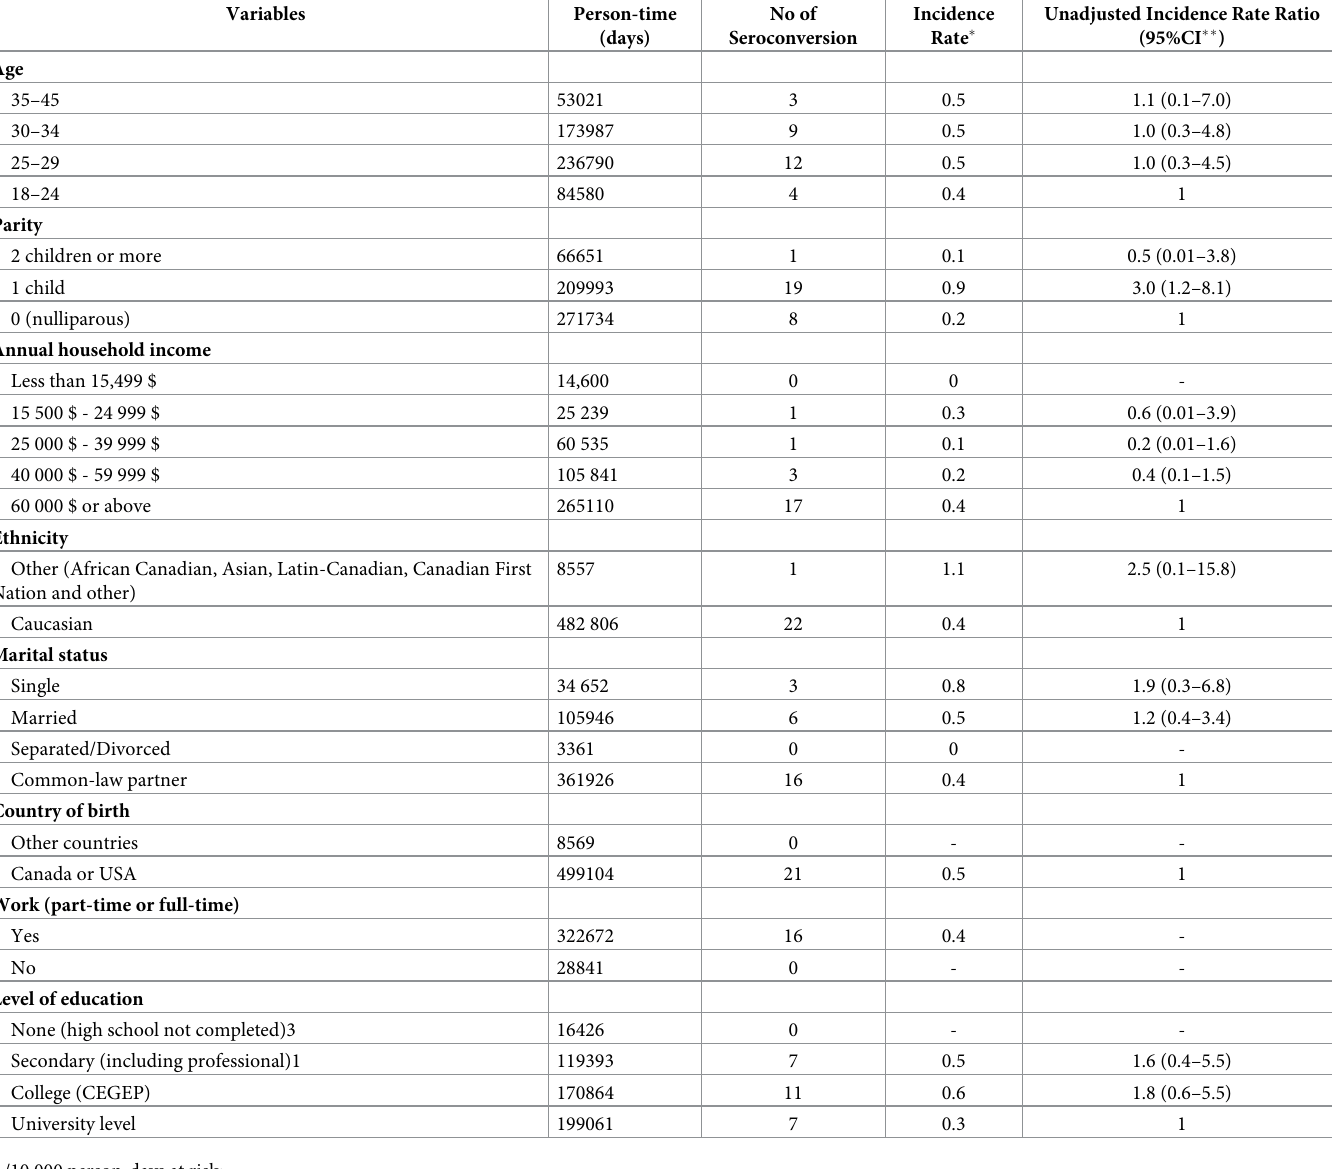
Table 2. Incidence of cytomegalovirus seroconversion in seronegative participants from the “Grossesse en sante´” cohort study, Que´bec, 2005–2010 (n =